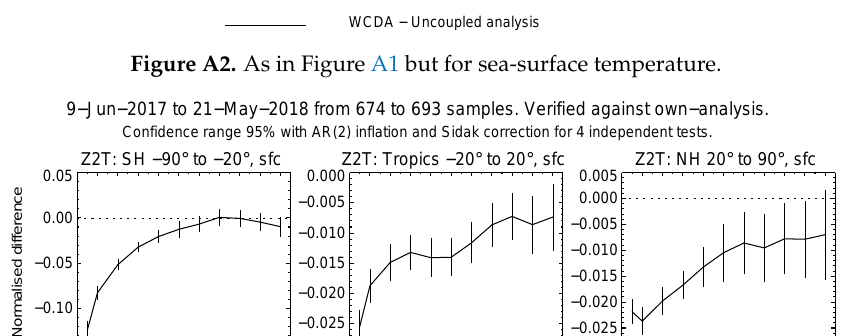
Figure A2. As Figure A1 but for sea-surface temperature.